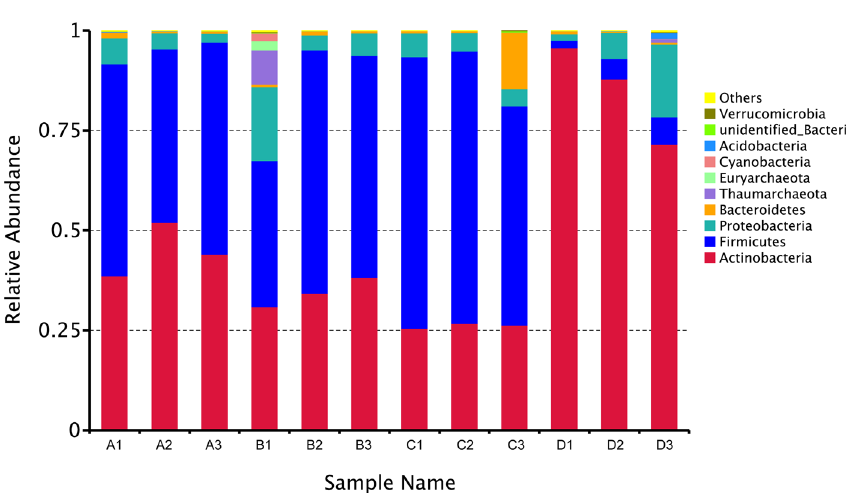
Figure 2. Bar plot of the relative abundances of microbial community at the rank of phyla